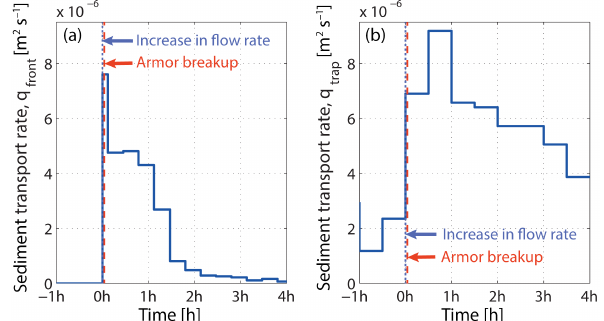
Figure 12. Measured sediment transport rate (a) computed from the migration of the front between the trimodal reach and the sand reach using Eq. (1), (b) at the downstream end of the flume. Horizontal line intervals indicate time-averaged